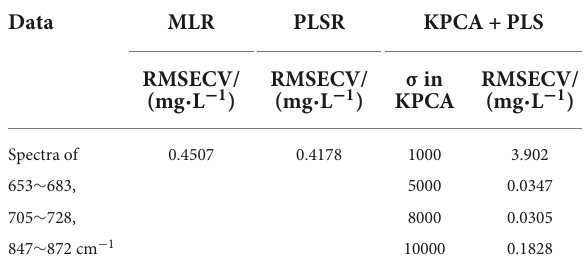
TABLE 1 Predicted results of the model developed using chemometric